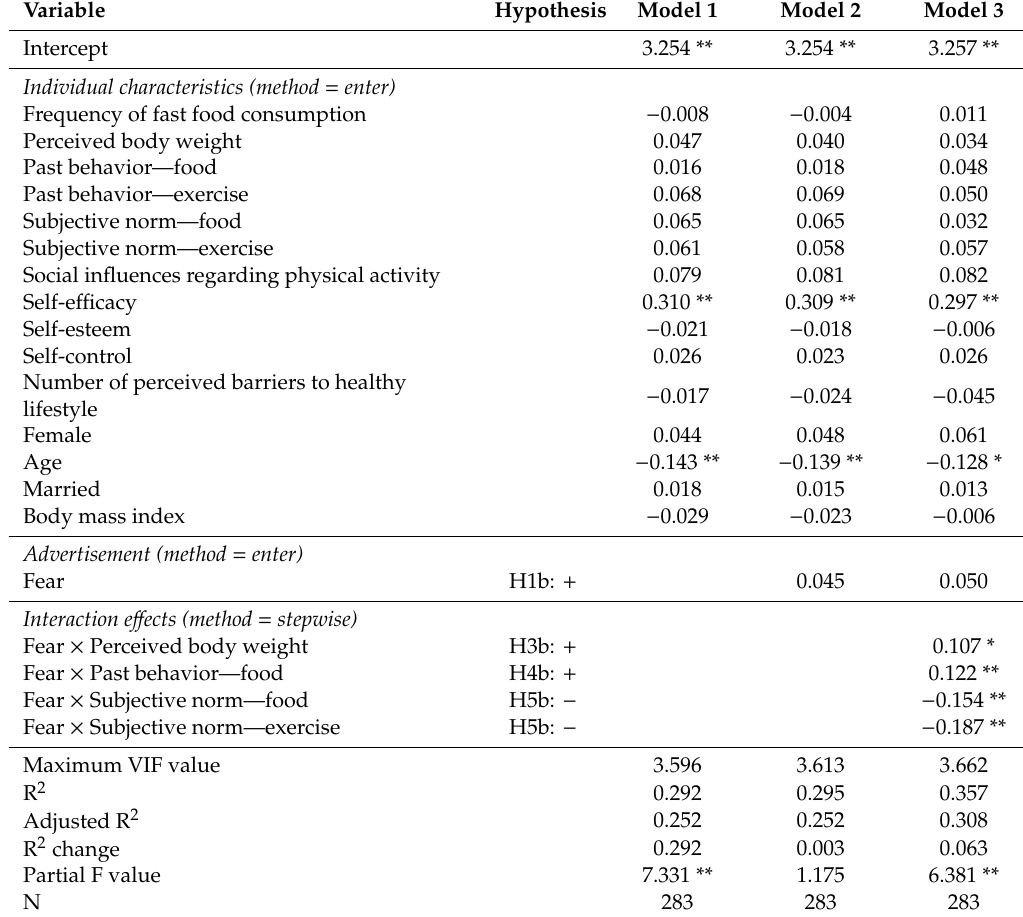
Table 4. Hierarchical linear regression predicting physical activity